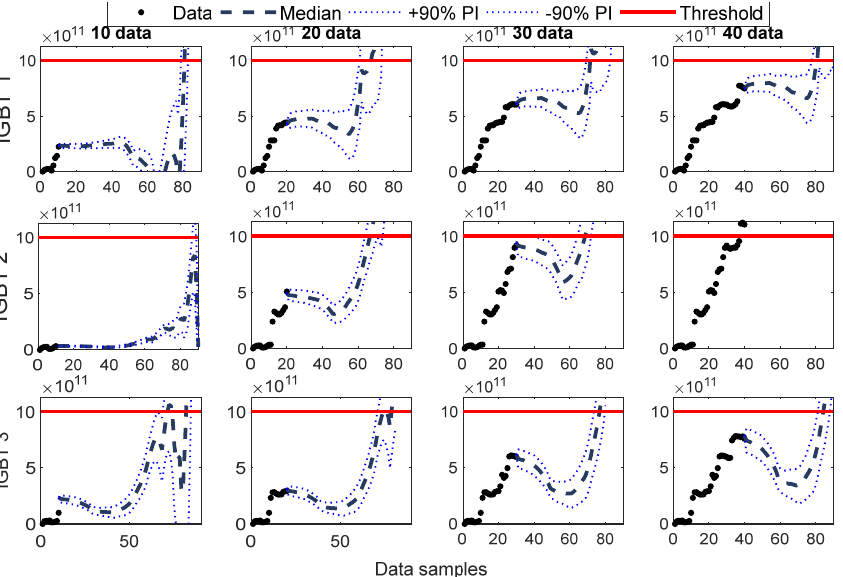
Figure 17. Degradation level under three cases with a different number of the available measurement data point. Reproduced from [17], IEEE.